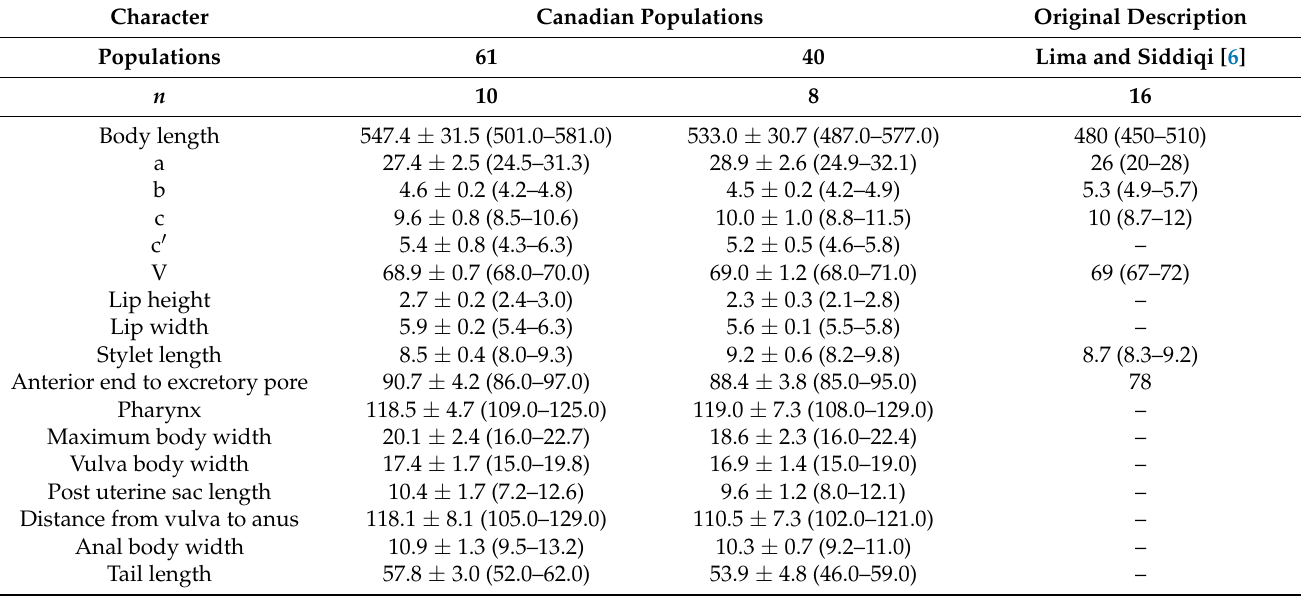
Table 4. Morphometrics of B. volutus female. All measurements are in µ m and presented as mean ± standard devia- tion